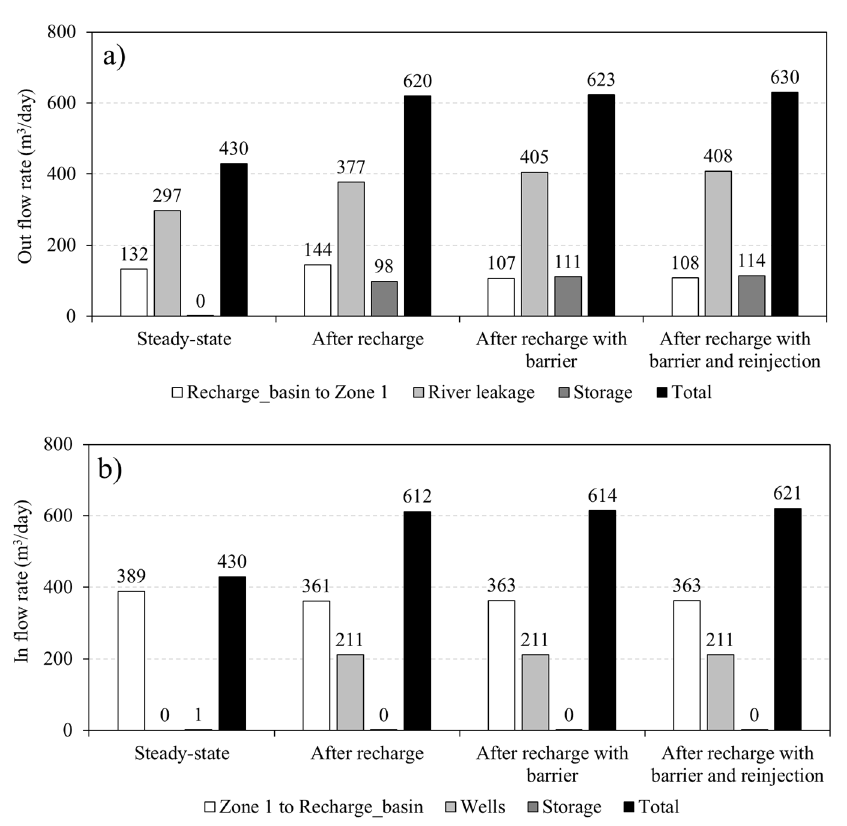
Figure 6. Result of water budget of three cases for the artificial recharge basin by using a numerical model: steady-state condition without artificial recharge, after 45 days recharge without underground barrier, after 45 days recharge with underground barrier, and after 45 days recharge with underground barrier and reinjection: ( a ) outflow rate, ( b ) inflow rate.